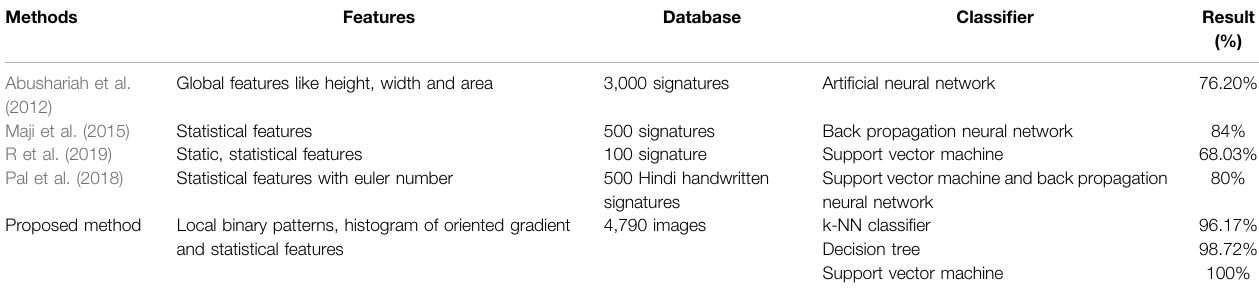
TABLE 3 | Summary of the related methods in the literature, features, classi fi ers and datasets used to achieve the reported classi fi cation